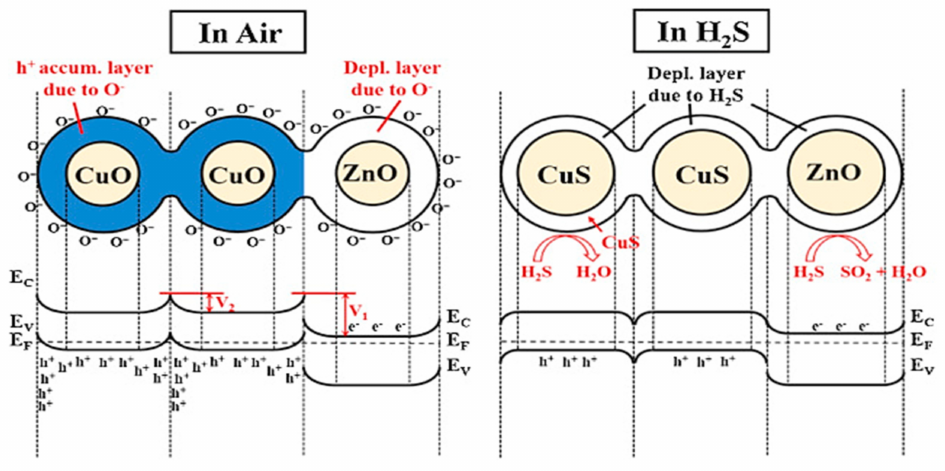
Figure 8. Schematic of energy levels in CuO-ZnO heterojunctions in air and H 2 S gas. Reprinted from [78] with permission from